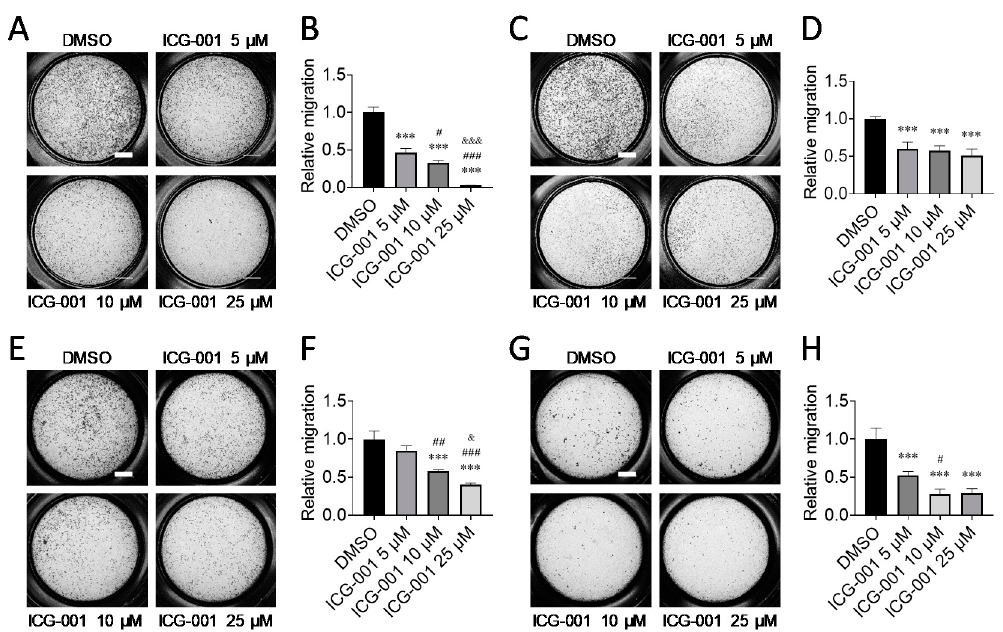
Figure 5. CBP / β -catenin antagonism suppresses migration of pancreatic stellate cells and pancreatic stellate cell-induced migration of pancreatic cancer cells. E ff ect of CBP / β -catenin antagonist ICG-001 versus control (DMSO) on migration of immortalized mouse pancreatic stellate cells (imPSC) (( A ), Crystal Violet staining of cells which migrated; and ( B ), relative migration) and on migration of immortalized human pancreatic stellate cells (ihPSC) (( C ), Crystal Violet staining of cells which migrated; and ( D ), relative migration), as assessed by Transwell migration assay. Note: imPSC and ihPSC were treated with ICG-001 for 48 h, after which time cells were seeded in serum-free medium onto 8- µ m Transwell insert, and the lower chamber was filled with 10% FBS medium. Cells were then allowed to migrate for 6 h (imPSC) or 24 h (ihPSC) and kept in corresponding concentrations of ICG-001 versus control (DMSO) during migration. E ff ect of ICG-001 on imPSC-induced migration of mouse pancreatic cancer cells Panc02 (( E ), Crystal Violet staining of cells which migrated; and ( F ), relative migration) and on ihPSC-induced migration of human pancreatic cancer cells PANC-1 (( G ), Crystal Violet staining of cells which migrated; and ( H ), relative migration), as assessed by Transwell migration assay. Note: For PSC-induced Panc02 and PANC-1 cell migration, imPSC and ihPSC were pre-treated with ICG-001 for 72 h, after which time respective PSCs were seeded in 10% FBS medium into the lower chamber and respective cancer cells were seeded in 10% FBS medium onto Transwell insert. Cells were then allowed to migrate for 24 h. Relative migration was determined by counting the number of cells which had migrated across the Transwell insert as assessed by Crystal Violet staining and then normalizing to control (DMSO). n = 3, *** p < 0.001 compared to control (DMSO), # p < 0.05, ## p < 0.01, ### p < 0.001 compared to ICG-001 5 µ M, & p < 0.05, &&& p < 0.001compared to ICG-001 10 µ M. Scale bar: 1 mm.